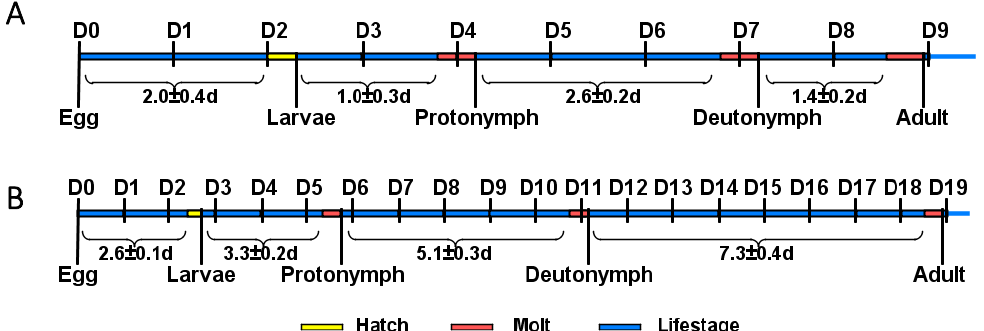
Figure 1. N. barkeri development. ( A ) Developmental period of N. barkeri under non-diapause conditions. ( B ) Developmental period of N. barkeri under diapause conditions. D = days, long blue bars denote life-stage, short yellow bars denote hatching, and short red bars denote molting.